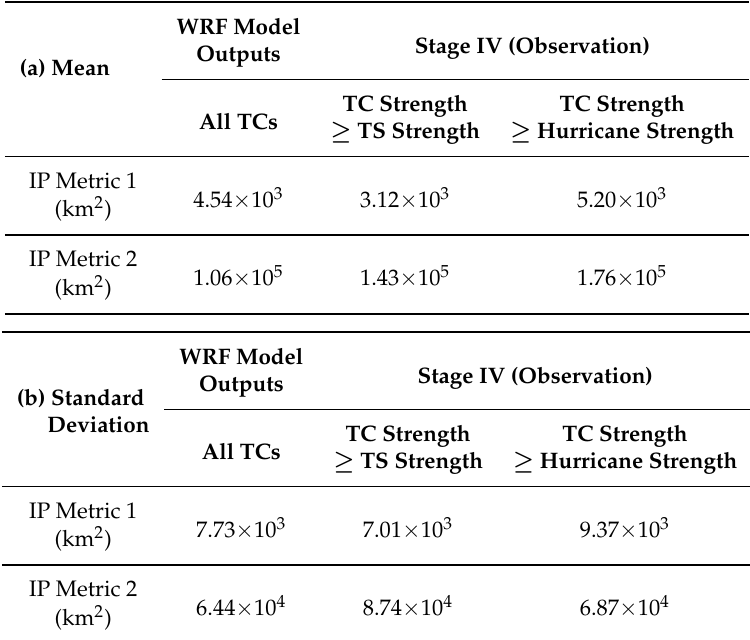
Table 4. WRF model validation results for the simulation of IP during the period 2005–2017 measured by (a) the mean and (b) the standard deviation of IP Metrics 1 and 2. These parameters were computed by calculating the mean and standard deviation during the period 2005–2017 of the metrics of all landfalling TCs in the WRF model outputs (Column 2), of all historical landfalling TCs (the list of which is given in the supplementary material Suppl.Mat._Historical_Landfalling_TCs.pdf ) with strength ≥ TS strength (Column 3), and of all historical landfalling TCs with strength ≥ hurricane strength (column